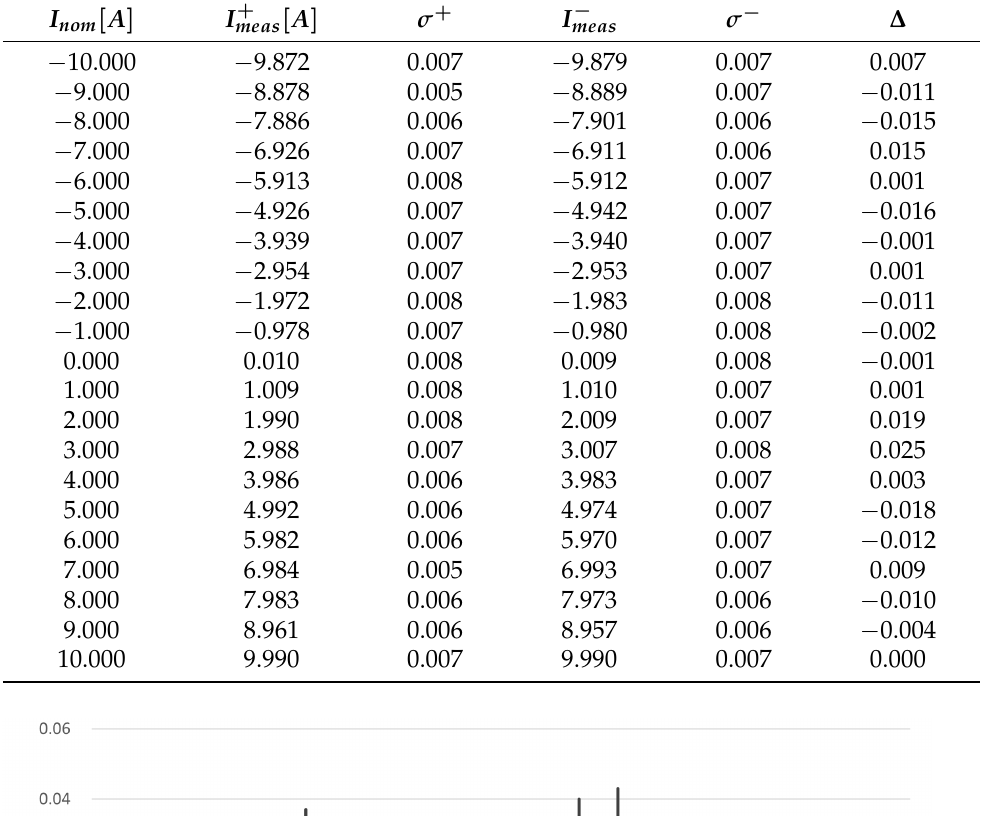
Table 2. Result of the test for the measurement hysteresis assessment.